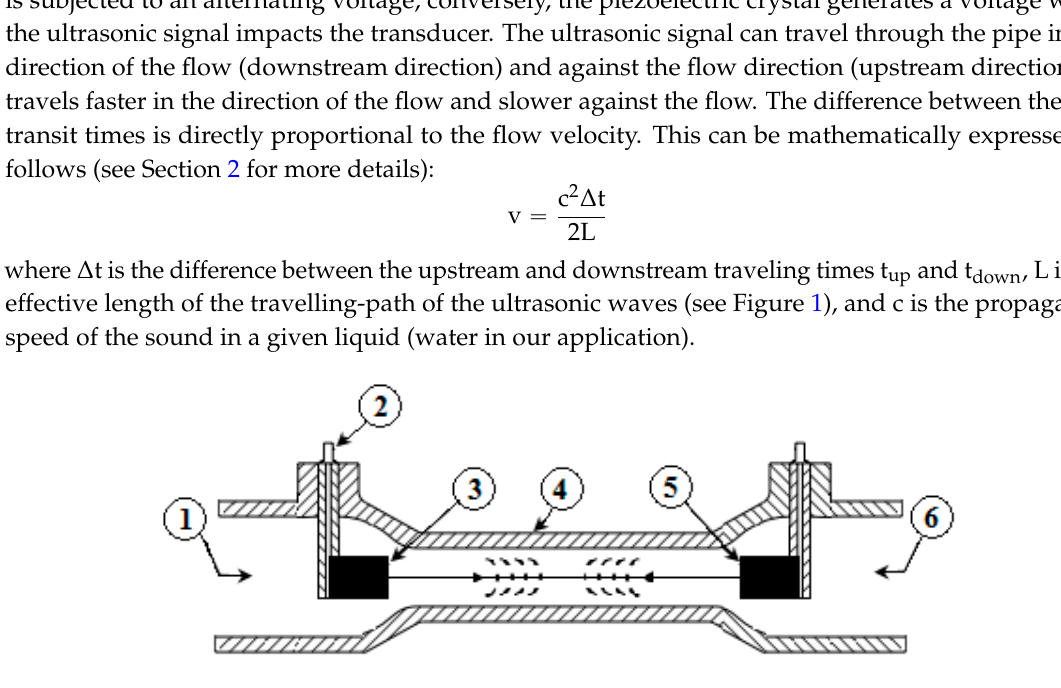
Figure 1. Flow meter pipe with in-line transducers: (1) inlet; (2) cable connector; (3) upstream transducer; (4) flow meter body; (5) downstream transducer; (6) outlet.